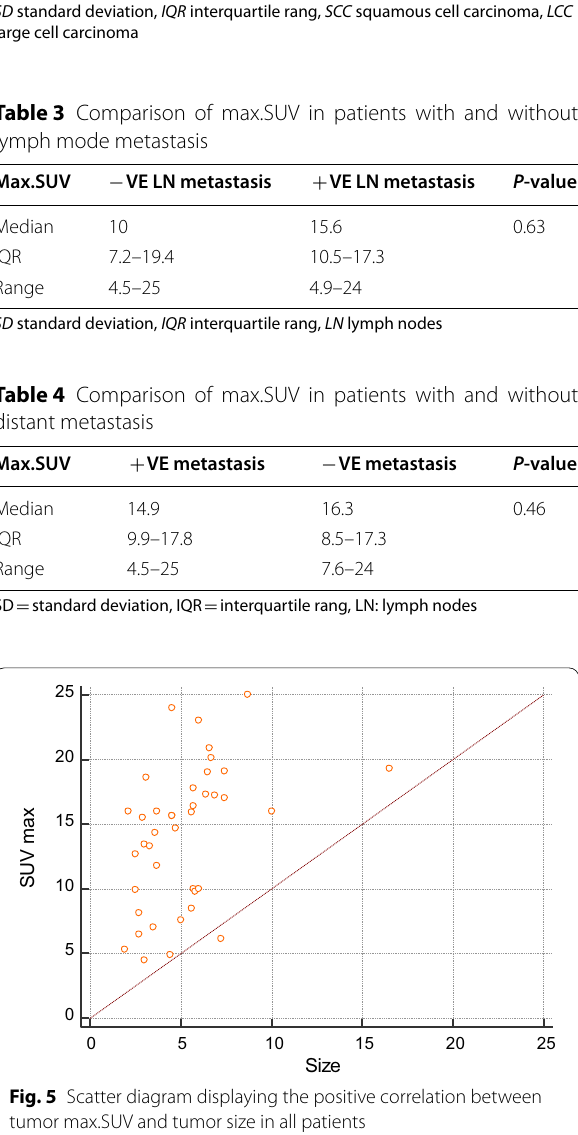
SD standard deviation, IQR interquartile rang, SCC squamous cell carcinoma, LCC large cell carcinoma